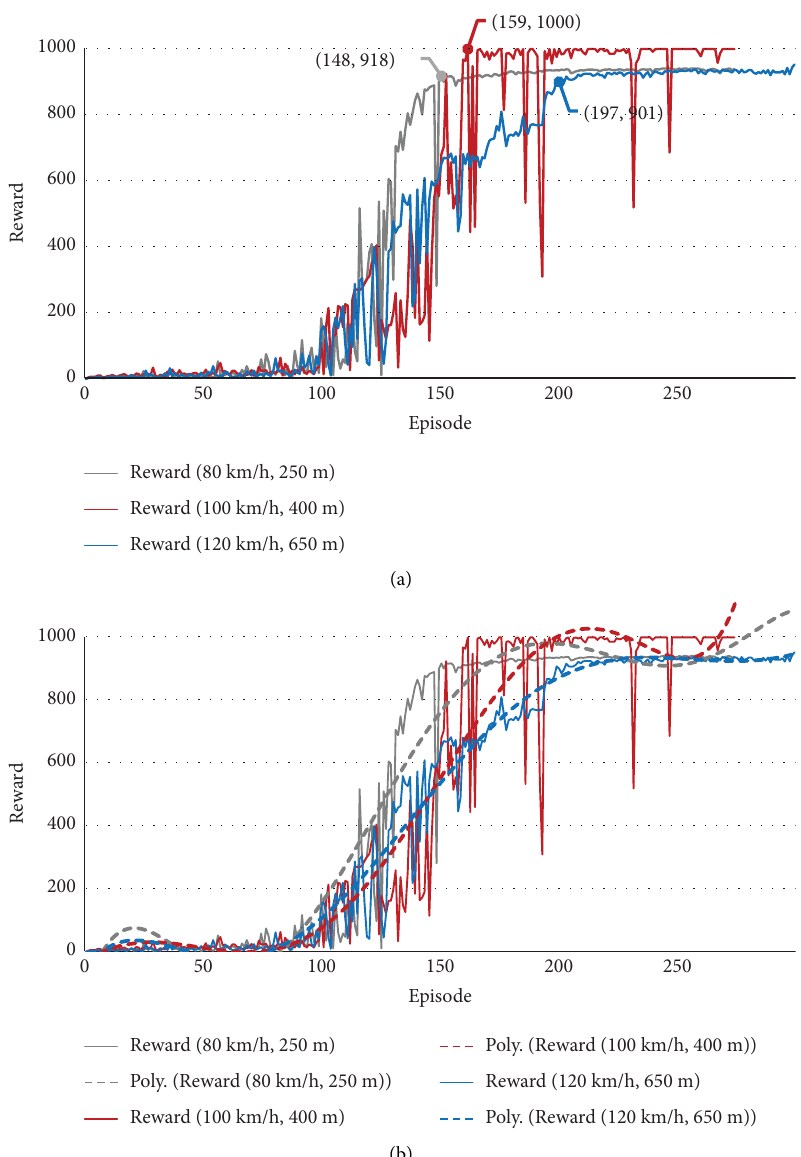
Figure 9: Training result: episode versus reward. (a) Episode versus reward with turning points. (b) Fitted episode versus